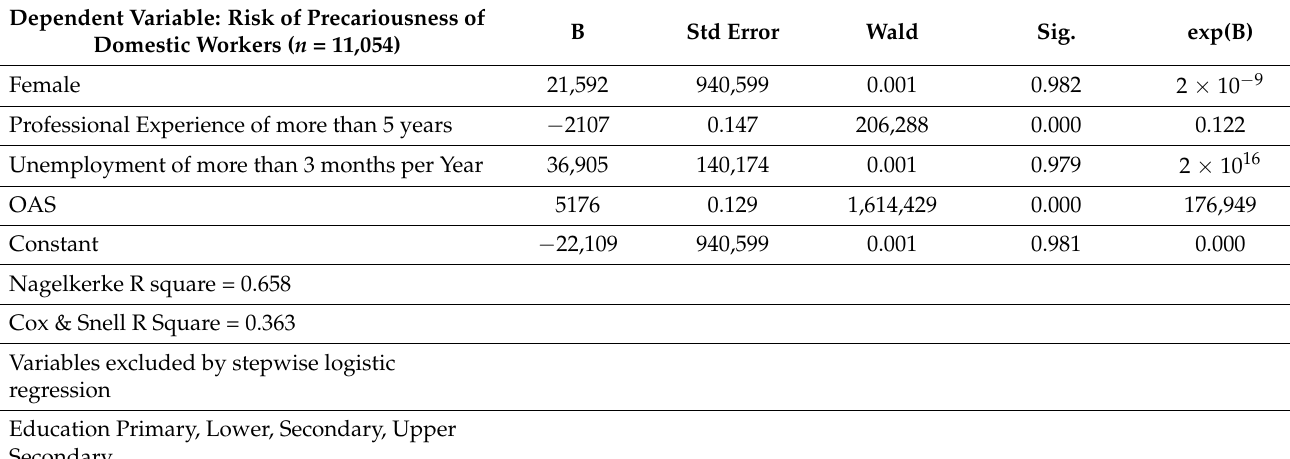
Table 5. The results of the stepwise logistic regression: personal characteristics affecting the risk of precariousness of domestic